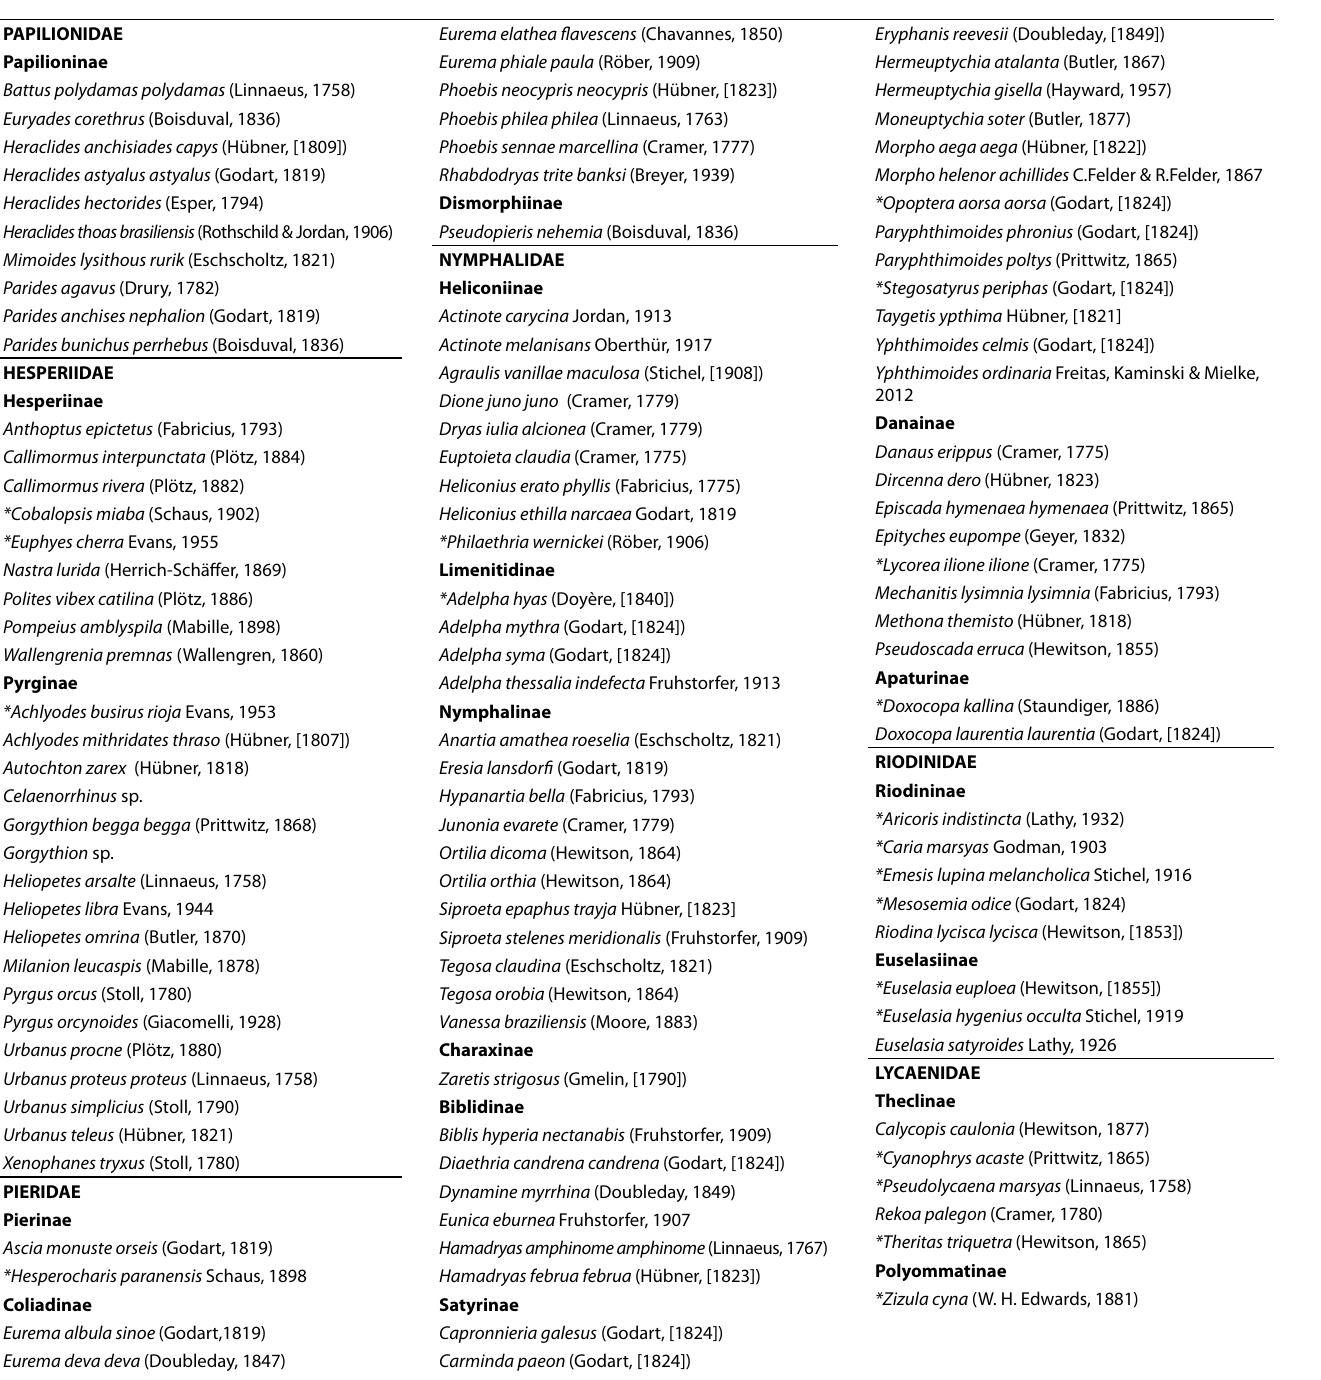
Table 1. Butterflies (Lepidoptera: Papilionoidea) recorded in two grassland areas in Santa Maria, Rio Grande do Sul state, Brazil, from 2009 to 2011. * Indicates first record in Santa